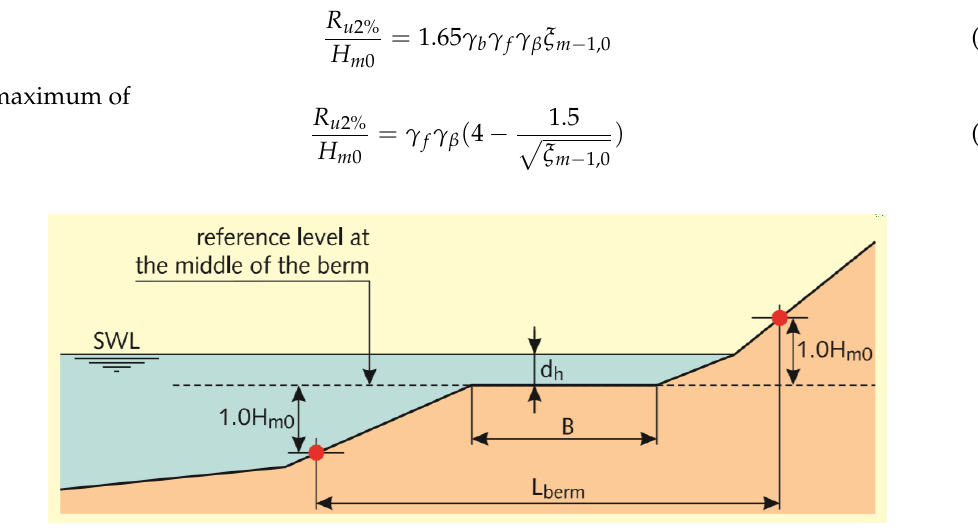
Figure A1. Definition of a berm of a dike from